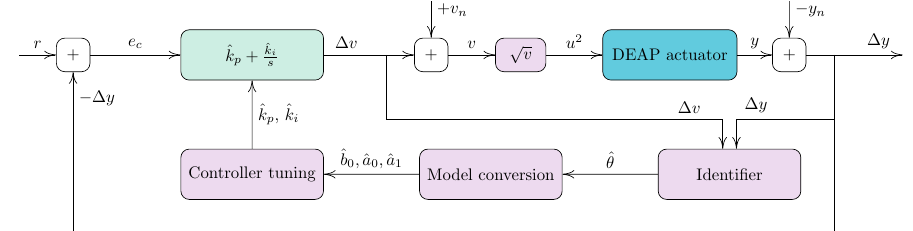
Figure 1. The schema of the PI controller with an online parameter